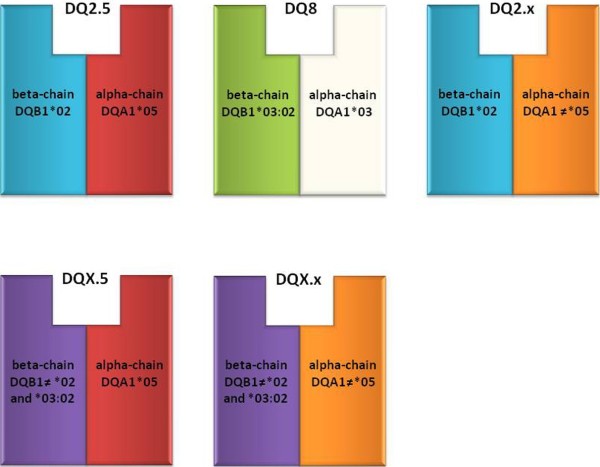
CD at-risk DQ heterodimers encoded by different combinations of DQA1and DQB1alleles.